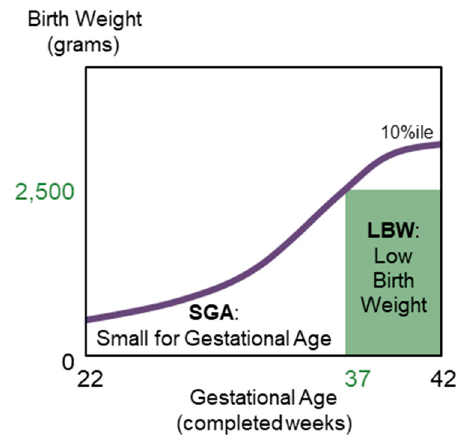
Figure 1. The set of birth weight–for–gestational age standards below the 10th percentile birth weights describes small for gestational age (SGA) in the purple curve; low birth weight at term (LBWT) is a subset of SGA in the green shaded rectangle.